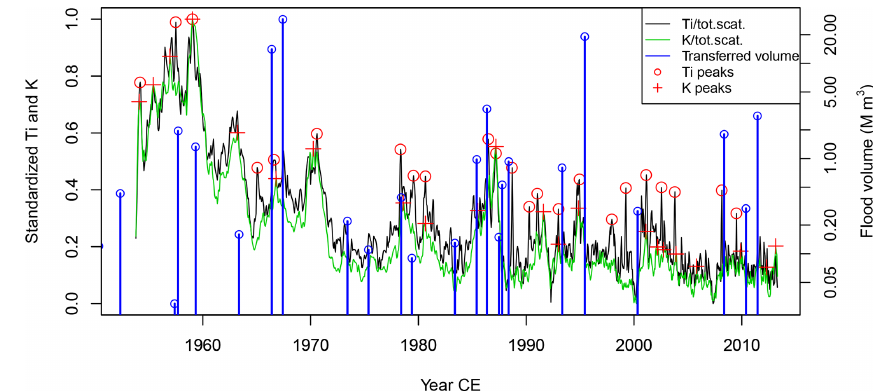
Figure 12. Transferred volume of the 23 bifurcation events in the period 1950–2013CE (in blue) and the 24 identified flood layers (red) identified using XRF scans of Ti / total scatter and K / totalscatter for FLS113.